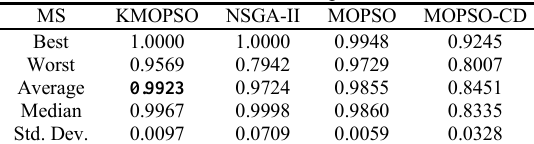
Table 16 . Results of the maximum spread metric for ZDT3.